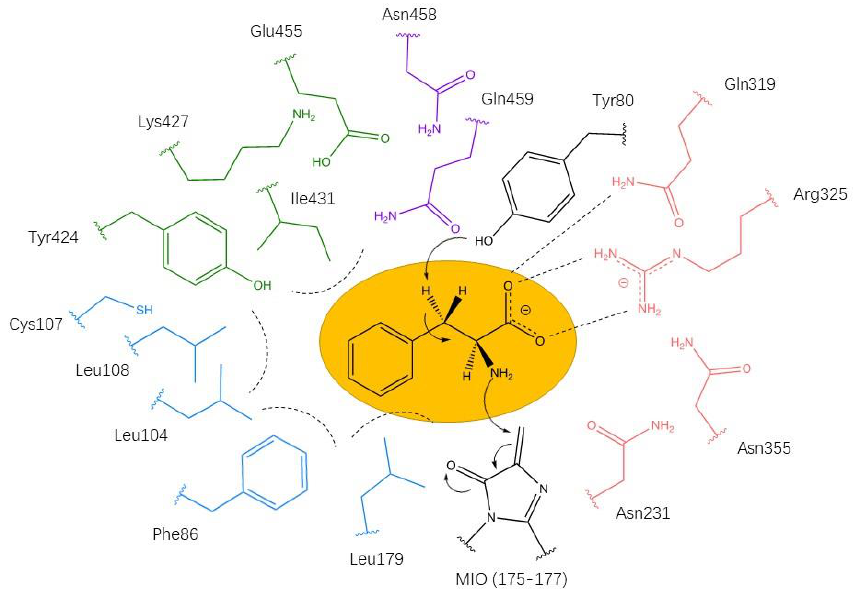
Figure 1. Schematic representation of the interactions between the natural substrate ( S )-α-phenylalanine and TchPAM (PDB ID: 4C5R). The color coding corresponds to the position of residues in the active site: carboxyl binding pocket (red), aromatic binding pocket (blue), tyrosine towards pocket (green), essential functional residues (black), and all other residues without specified function (purple). The substrate (e.g., ( S )-α-phenylalanine) is highlighted by a yellow background.